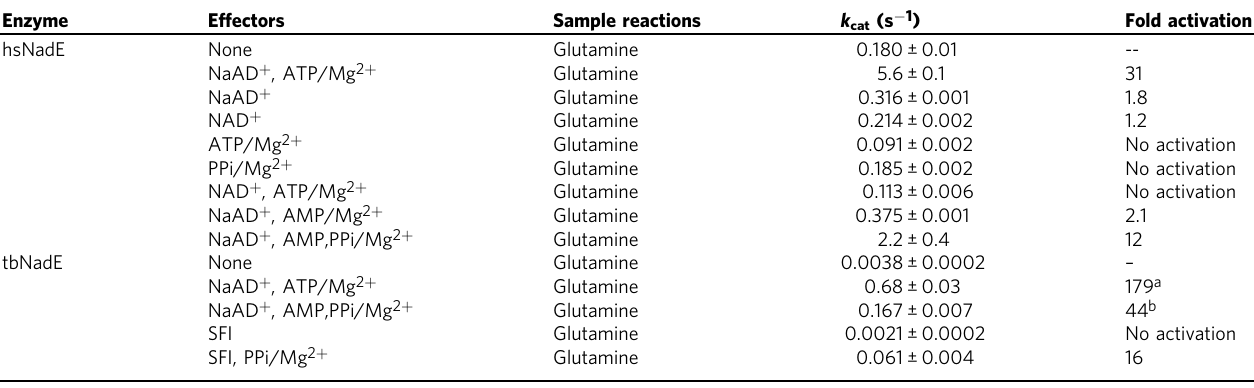
Table 2 Glutaminase activation of hsNadE and tbNadE.